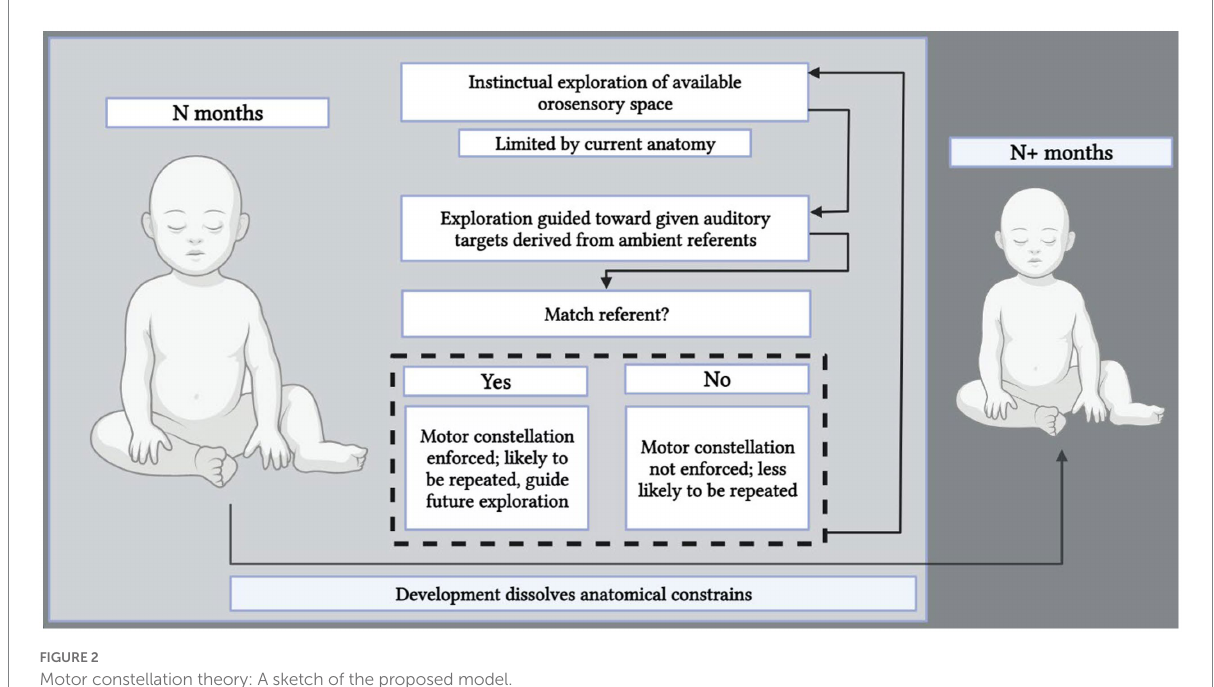
FIGURE 2 Motor constellation theory: A sketch of the proposed